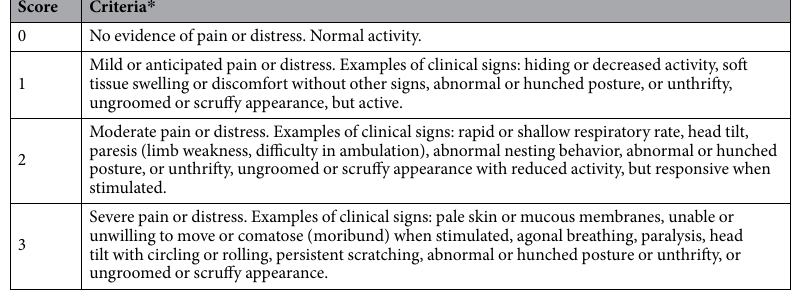
Table 1. Experimental endpoint criteria. * Scoring is based on the presence of one or more clinical signs within the example list. Guinea pigs were considered moribund and were euthanized after reaching a score of